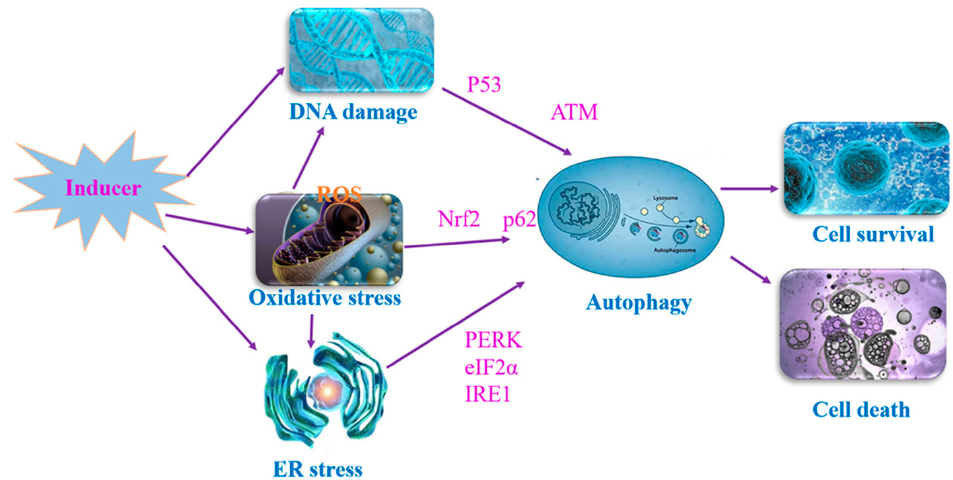
Figure 2. Molecular pathways involved in the regulation of autophagy. Oxidative stress induced DNA damage and ER stress, which caused autophagy development. Autophagy has a dual nature, which can not only save cell survival, but also promote cell death.